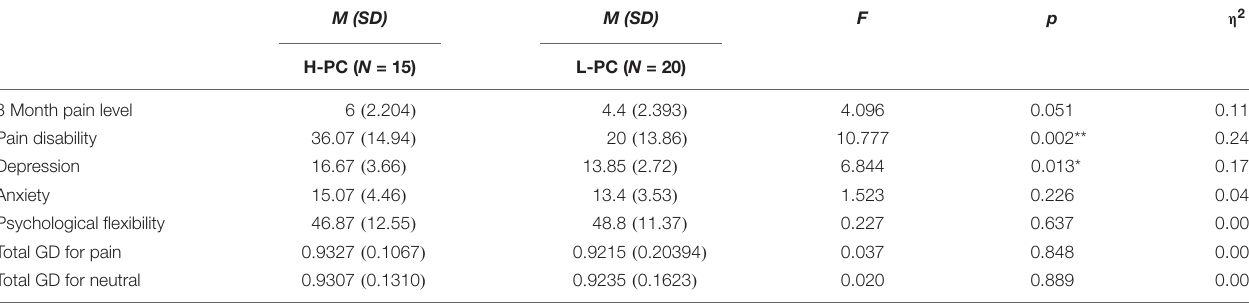
TABLE 5 | Mean/SD of psychological factors and total gaze durations by two pain catastrophizing groups. M